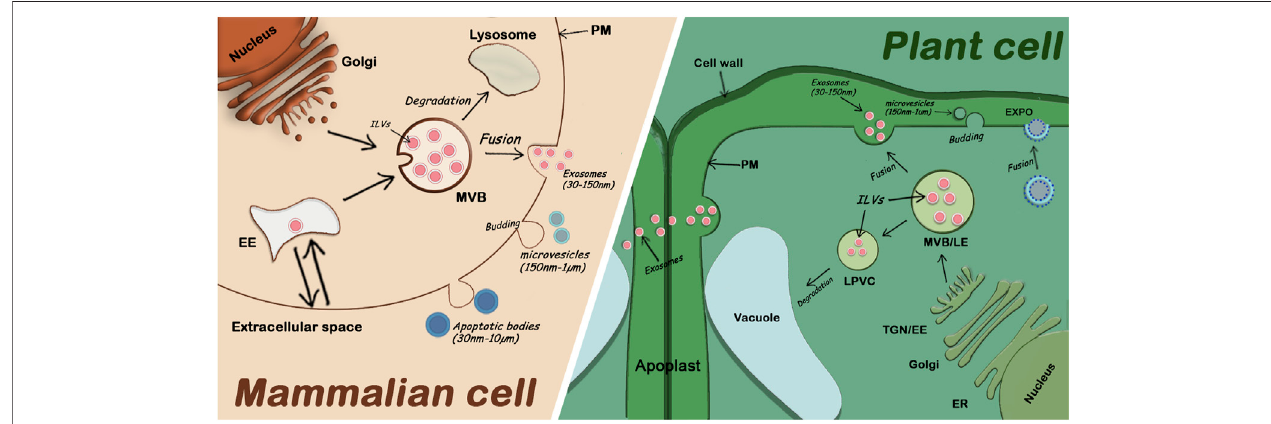
FIGURE 1 | Comparison of extracellular vesicle secretion in mammalian cells and plant cells. Mammalian EVs including apoptotic bodies, microvesicles, and exosomesaresecretedintheextracellularmedium.PlantEVsarealsosecretedintheextracellularmedium(theapoplast).ExosomesaresecretedbyfusionofMVBswith the PM, EXPO vesicles are also secreted by fusion with the PM while microvesicles and apoptotic bodies are released through budding of the PM. EE: Early Endosome; ER: Endoplasmic Reticulum; ILVs: Intraluminal Vesicles; LE: Late Endosome; LPVC: Late Pre-vacuolar Compartment; MVB: Multivesicular Body; PM: Plasma Membrane; TGN: Trans Golgi Network; (proportions of organelle sizes not